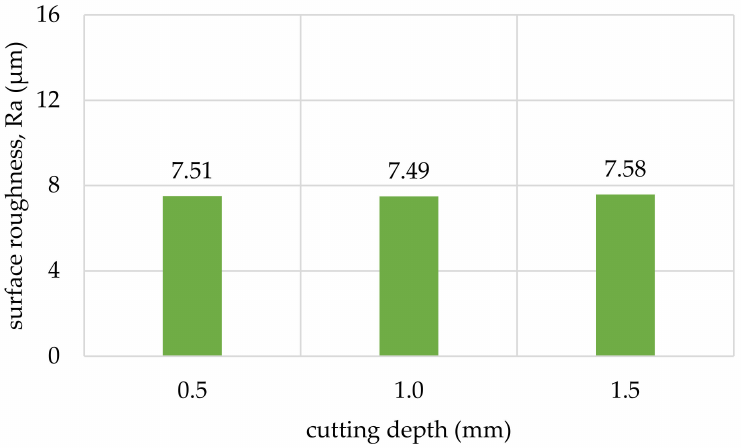
Figure 14. Average surface roughness obtained in all tests depending on the cutting depth.